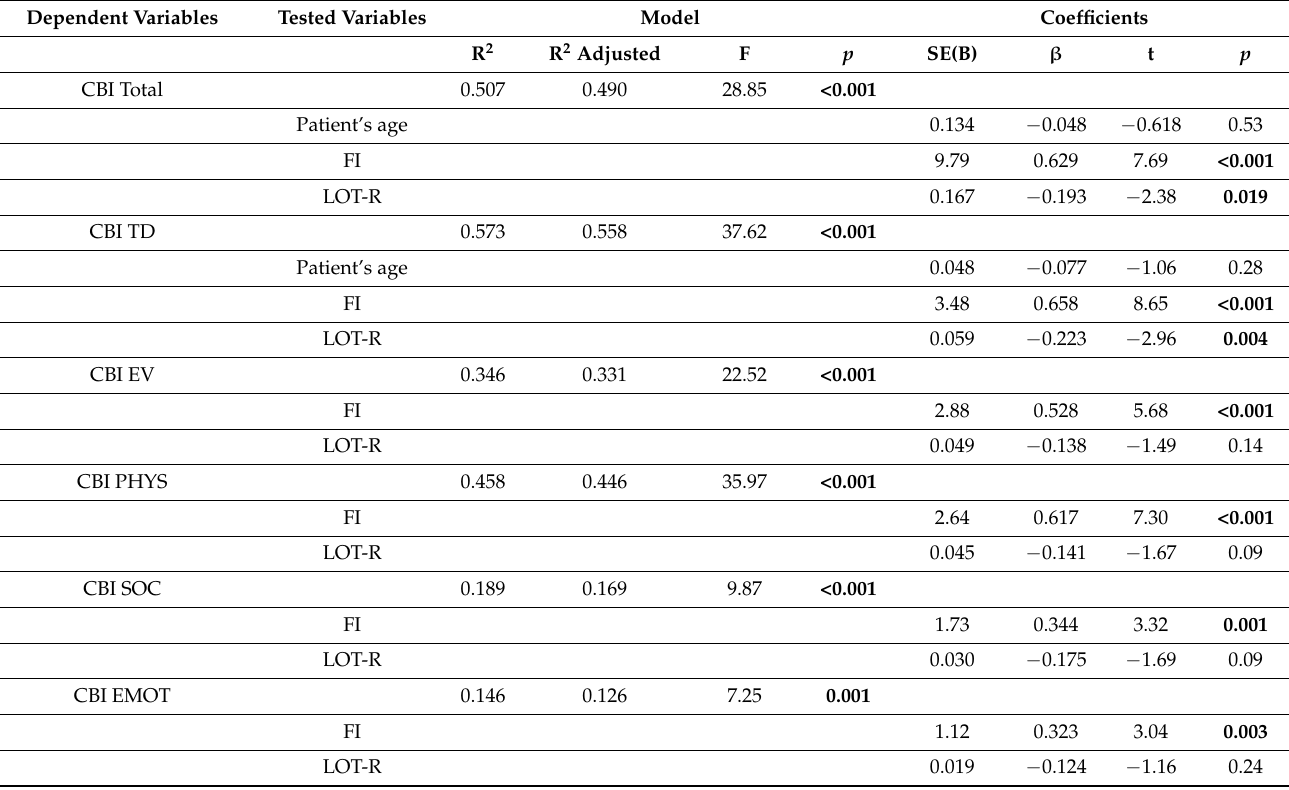
Table 3. Multivariate linear regressions for the caregiver burden